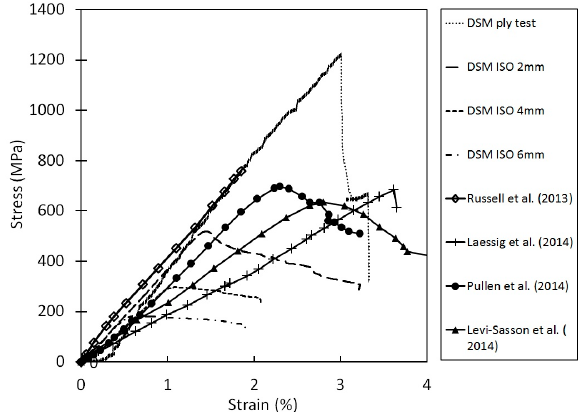
Figure 8. Tensile testing of Dyneema ® at varying thicknesses by different researchers [19].